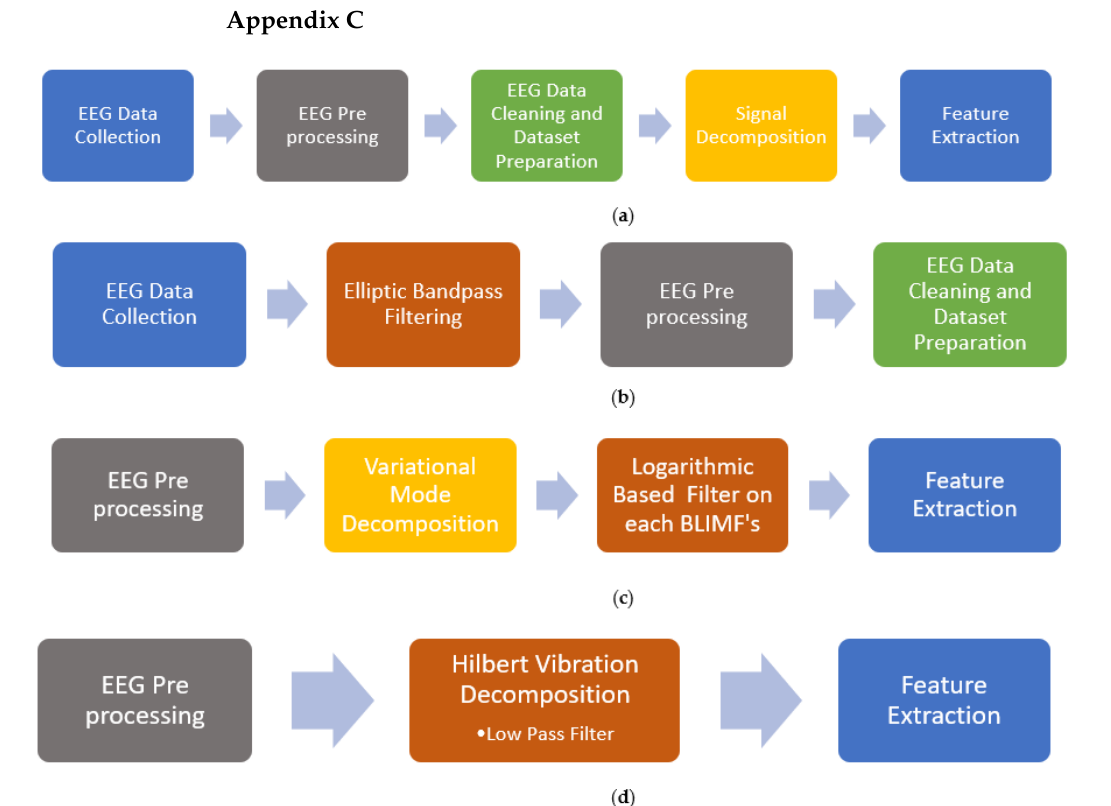
Figure A1. EEG pre-processing techniques and EEG artifacts/data cleaning used in this review. ( a ) The first five processes of epileptic seizure data classification as in Figure 2. ( b ) The epileptic filter used to bandpass the frequency from 0.5 Hz to 60 Hz in study [12]. ( c ) The logarithmic operation applied to each BLIMF after decomposition in study [16]. ( d ) The 4th order Butterworth low-pass filter embedded in the decomposition phase in study